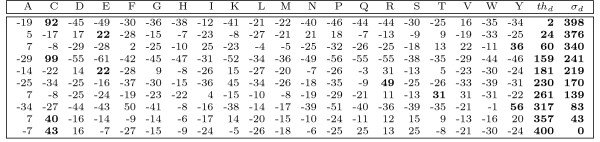
Amino acid PSSM. Amino acid PSSM of length m = 10 of a zinc-finger motif. If the score threshold is th = 400, then only substrings beginning with C or V can match the PSSM, because all other amino acids score below the intermediate threshold th0 = th - σ0 = 400 - 398 = 2. That is, lookahead scoring will skip over all substrings which begin with amino acids different from C and V. Here σd, d ∈ [0, m - 1] denotes the maximal score that can be achieved in the last m - d - 1 positions of the PSSM as defined in the text.